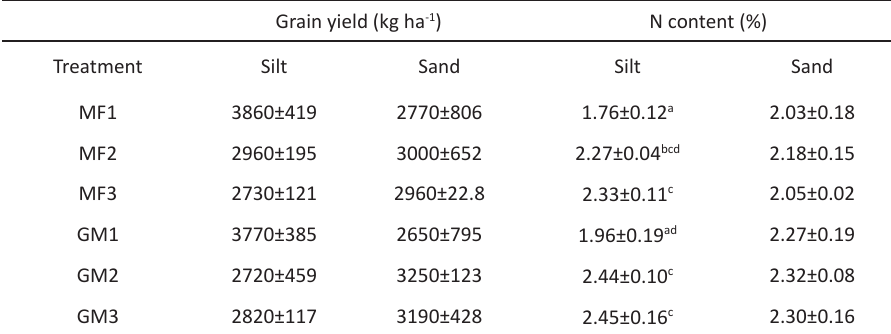
Table 2. Crop grain yield and N content of the grains (±standard deviation; n=3 or 4) Grain yield (kg ha -1 ) N content (%) Treatment Silt Sand